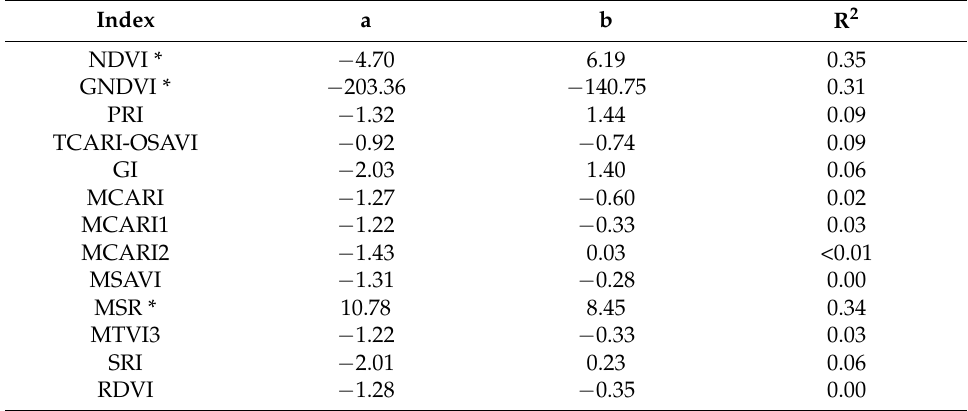
Table 3. Linear correlations between multispectral indices and midday stem water potential ( Ψ stem ).